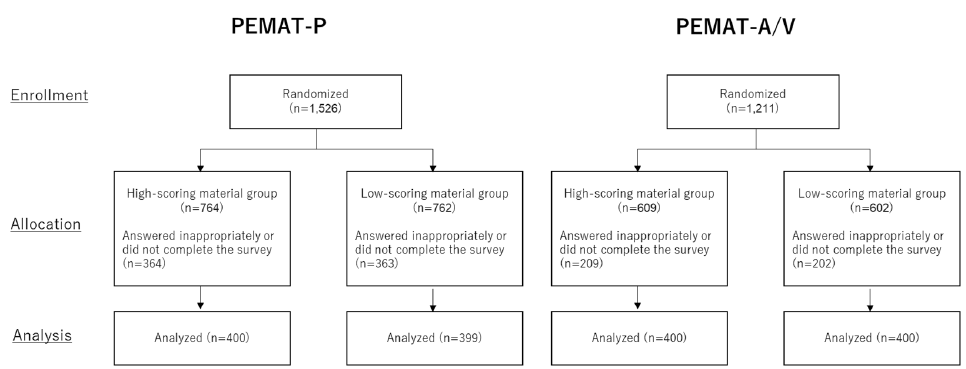
Figure 1. Flow diagram of the participants. Table 3. Demographic characteristics of participants (PEMAT-P).